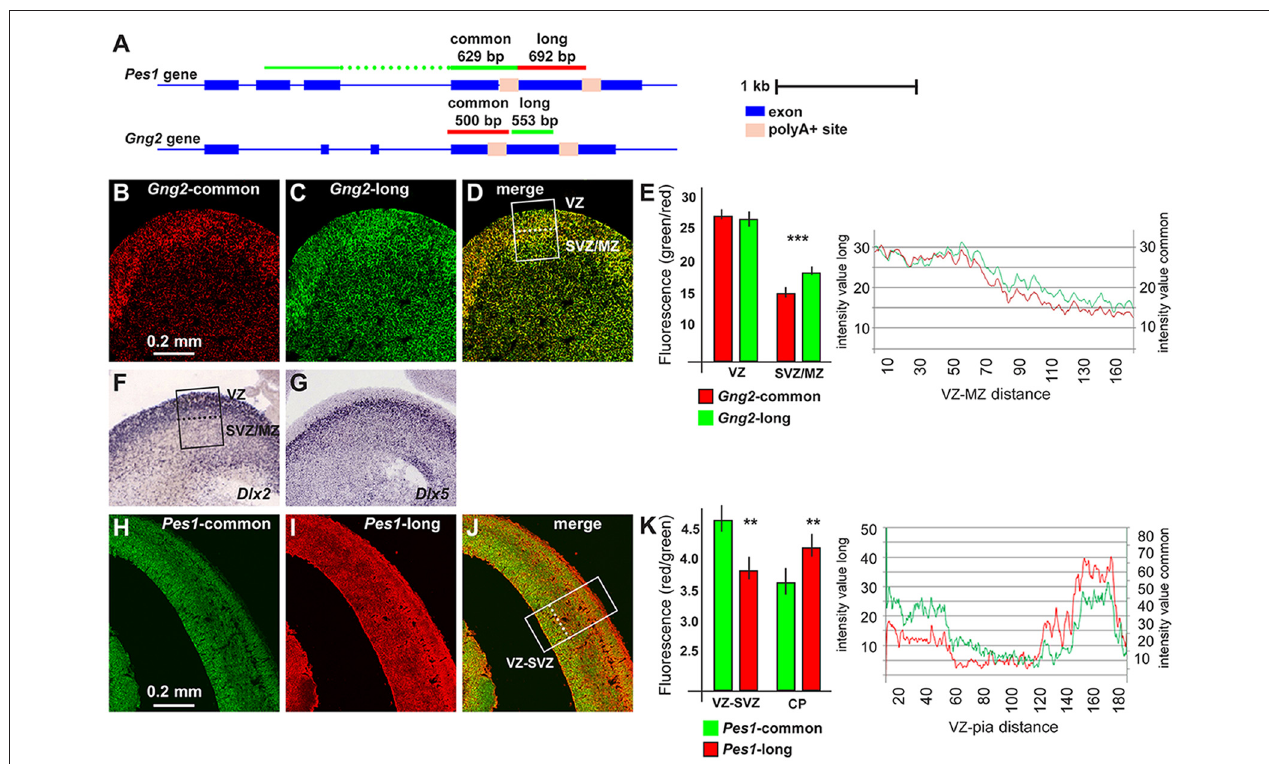
FIGURE 2 | Pes1 and Gng2 transcript variants in the mouse embryonic brain. Detection and localization of variants of Pes1 and Gng2 transcripts in the mouse embryonic cortex and ganglionic eminence (GE) of the forebrain, to reveal differential abundance in proliferating vs. differentiating regions. (A) Scheme showing the Gng2 and Pes1 gene organization, the location of the alternative polyA+ sites and of the probes used to detect all variants (common) or the long-variants. Scale is shown on the right. (B–D) Coronal sections of normal mouse embryonic forebrain at the age E14.5 subjected to two-colors fluorescent in situ hybridization (FISH) to determine the localization and relative abundance of variants of the Gng2 mRNAs. At least 10 sections were stained, obtained from two brain specimens. Representative images of two-colors FISH to detect all variants (red, in B ) or the long variant (green, in C ) Gng2 transcripts in the basal brain primordium. A merged image is shown in (D) . (E) Histogram and profile of the relative fluorescent intensity of the images in (B–D) , from the area indicated in ( D ; white rectangle, subdivided in ventricular zone(VZ) and subventricular/mantle zone (SVZ/MZ). At least two areas/slide were considered. The results relative to the VZ or the SVZ/MZ are shown as histogram. Gng2 -all variants is indicated with red bars and lines, the Gng2 -long variant is indicated with green bars and lines. Note the relative increase in the relative fluorescent detected in the SVZ/MZ area. (F,G) Images of the expression and localization of Dlx2 (F) and Dlx5 (G) mRNAs by ISH (from www.genepaint.org) marking, respectively, proliferating progenitors and committed/early differentiating GABAergic neurons. The position of the VZ and SVZ/MZ is indicated in (F) . (H–J) Representative images of two-colors FISH to detect all variants (green, in F ) or the long variant (red, in G ) Pes1 transcripts in the cortical primordium. A merge image is shown in (H) . (K) Histogram and profile of the relative fluorescent intensity of the cortical primordium, from the areas indicated in ( H ; (white rectangle, subdivided in VZ/SVZ and cortical plate (CP)). At least two areas/slide were considered. The results relative to the VZ/SVZ or the CP are shown as histogram. Pes1 -all variants are indicated with green bars and lines, Pes1 -long variant is indicated with red bars and lines. Note the relative increase in the relative fluorescence detected in the CP. Asterisks indicate statistical significance, ∗∗ p < 0.01, ∗∗∗ p < 0.001.